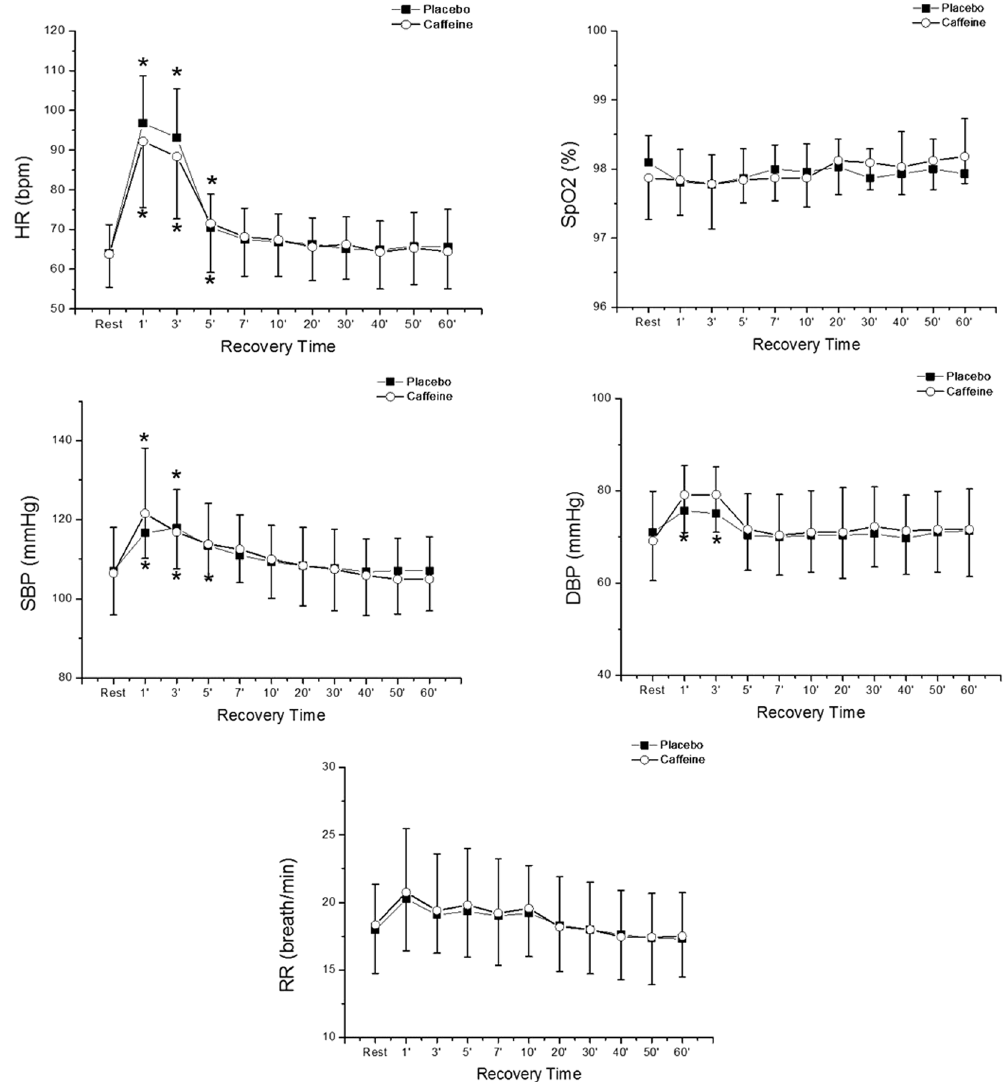
Figure 2. Mean values and respective standard deviations of heart rate (HR), oxygen saturation (SpO2), systolic blood pressure (SBP), diastolic blood pressure and (DBP) respiratory rate (RR) obtained in the placebo and caffeine protocols at rest and during recovery (Rec). * Values with significant difference in relation to rest (Friedman test followed by the Dunn test, p <